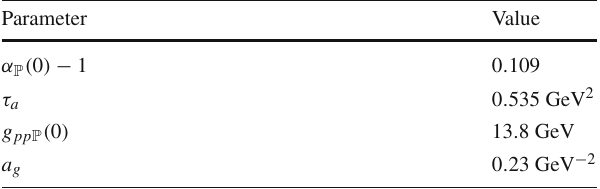
Table 1 Parameters for proton–proton elastic scattering amplitude Parameter Value